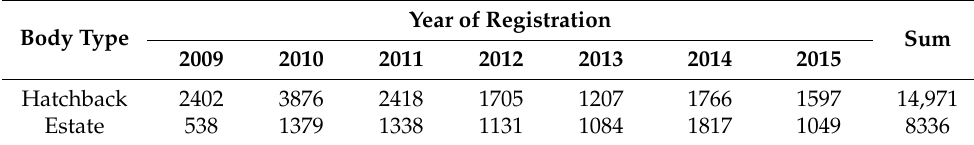
Table 6. Number of registered cars in 2009–2015 in Poland.